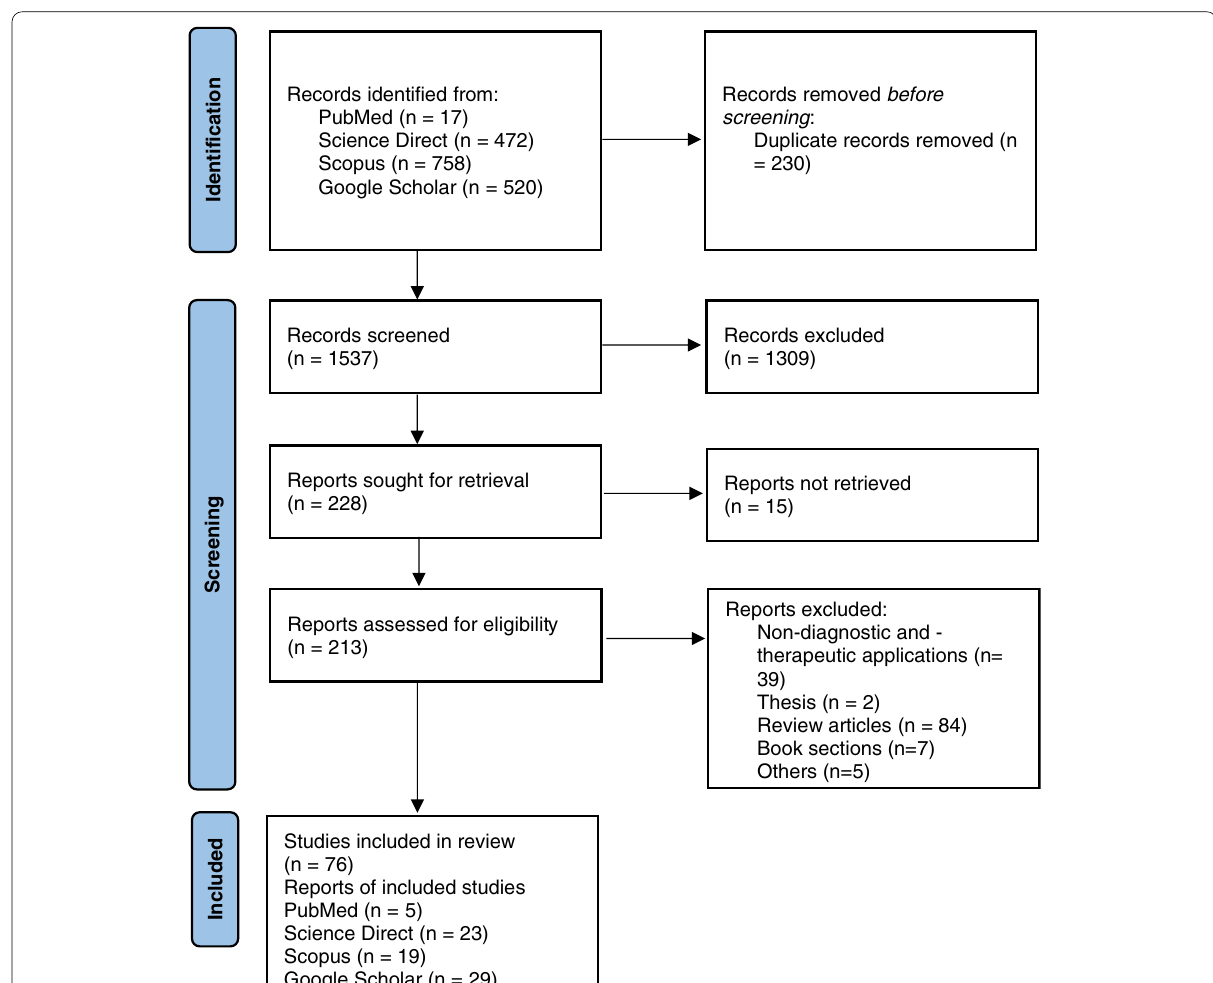
Fig. 2 PRISMA chart. The flow chart shows a detailed presentation of the number of studies retrieved, deduplicated, excluded during screening, and included in this